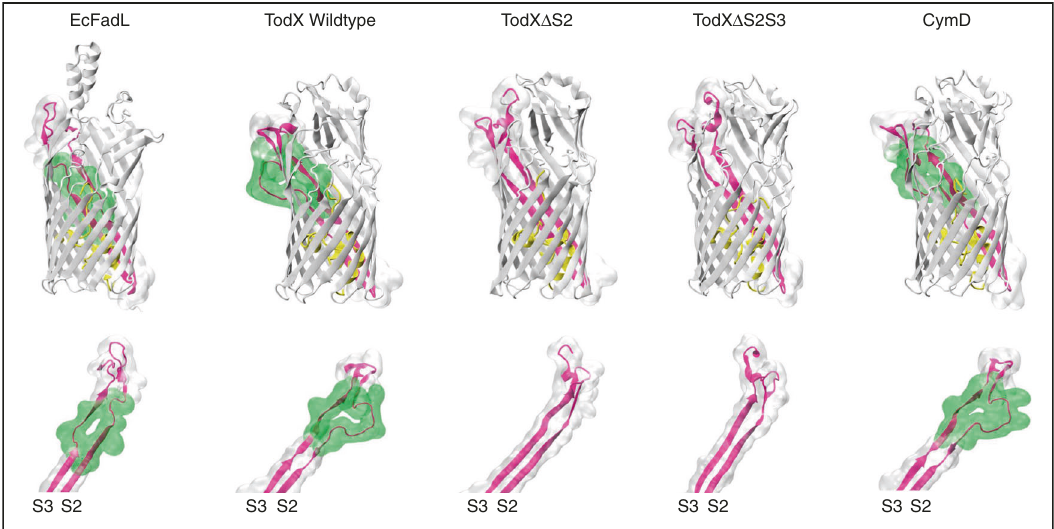
Fig. 4 Lateral opening mutants of TodX. Structures of the FadL channels discussed in this study. The lateral openings (delineated by the green surface) are similar in size in the wild-type structures of TodX and CymD and differ only slightly from EcFadL, in that the latter does not have a bulge in S2 like TodX and CymD, but a more pronounced kink in S3. The two TodX mutant channels Δ S2 and Δ S2S3 have much smaller lateral openings, while retaining overall high structural similarity to the wild-type